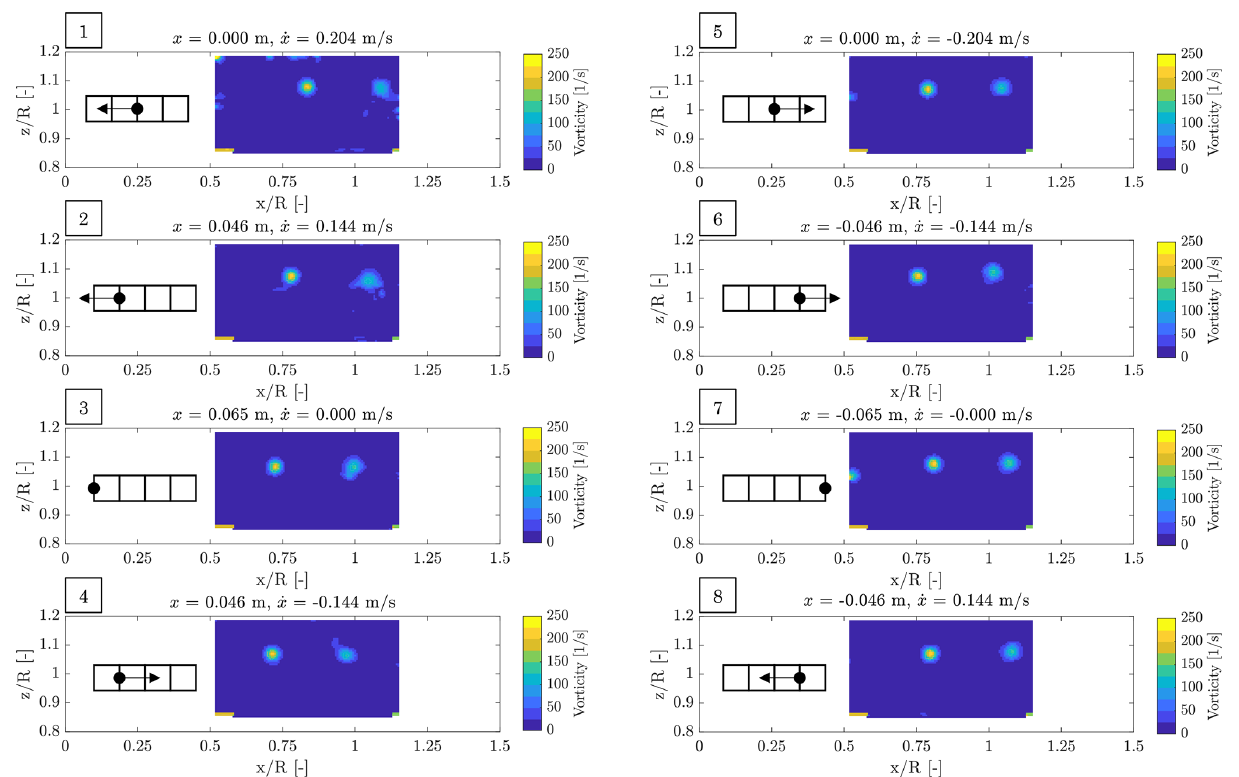
Figure 15. Vorticity for eight subsequent wind turbine positions in a surge cycle of frequency 0.5Hz, amplitude 0.065m, and RATED2 conditions. The blade-1 azimuth is always 0 ◦ . x/R and z/R are the axial and vertical distance from rotor apex normalized by rotor radius. The origin of the axes is coincident with the rotor apex when the wind turbine is in the zero-surge position (see the Results ref. frame of Fig.